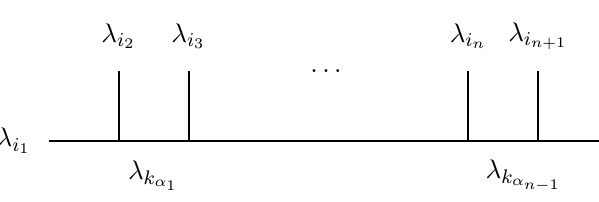
= ∆ as well as ∆ 0 = ∆ in i a − λ j k αa − λ k αa i a k αa